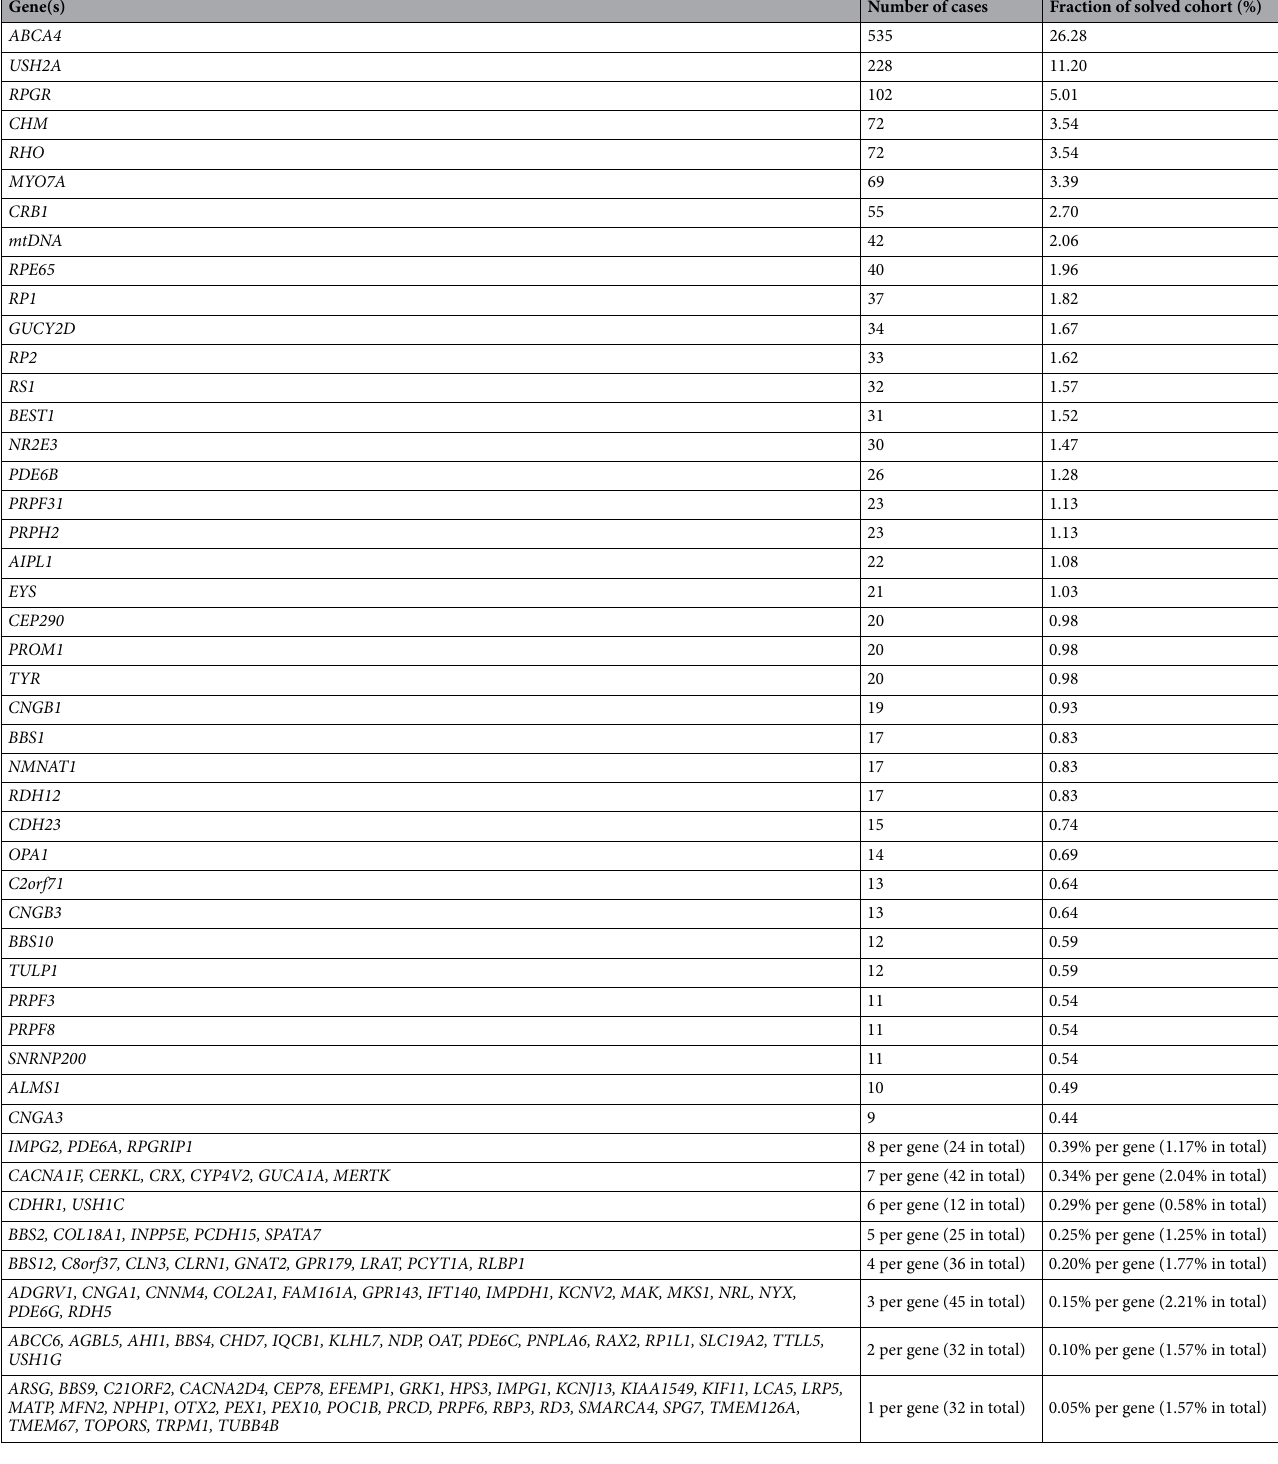
Table 3. Contribution of causative